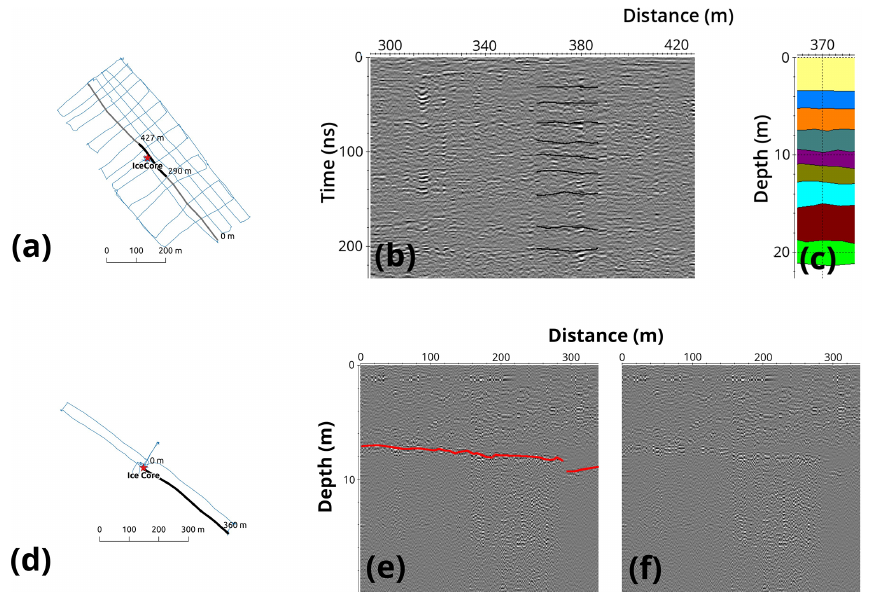
Figure 6. Mertz GPR. Reference maps of (a) Mertz 1 and (d) Mertz fast-ice sites depicting the full track of measurements (blue), the profile (grey), and the section shown in the radargram (black). (b) Radargram representing a section of a transect crossing the ice core extraction point at Mertz 1 with layer interpretation and (c) estimated depth of layers. (e) Radargram collected at the fast-ice site, shown with one detected layer in red and (f) without layer